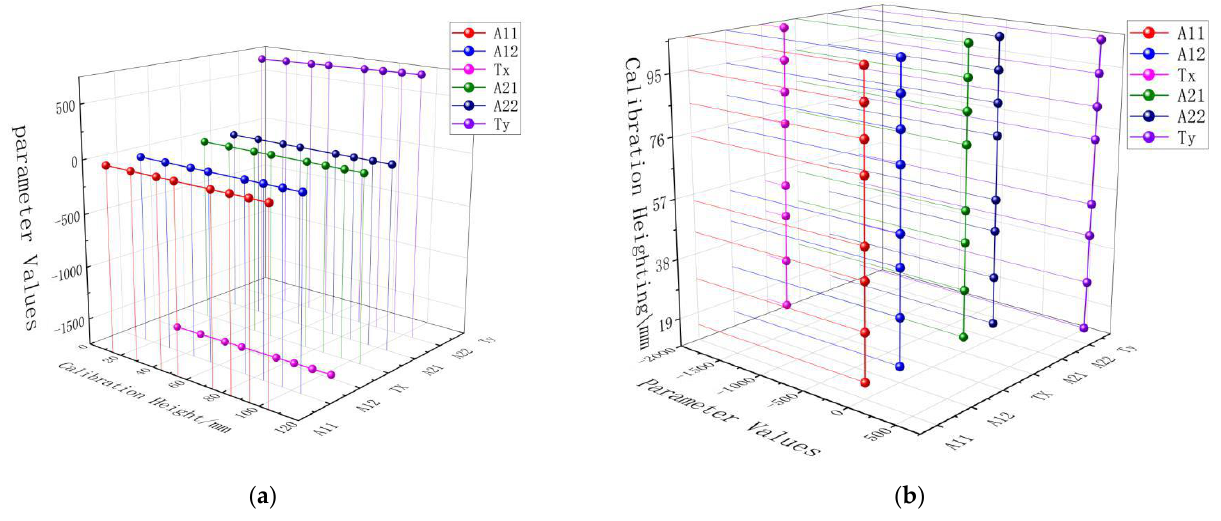
Figure 10. Broken line diagram of rigid transformation matrix parameters and calibrated height parameters: ( a ) The Z − axis is the parameter value, and ( b ) Z − axis is the calibration height. It can be seen from Figure 10 that 𝑀 𝐶𝑅 matrix parameters show an obvious linear rlationship with the broken line diagram of H . Tx and Ty reflect the change in the trans- lation matrix. A11, A12, A13, and A14 are all near the z = 0 plane, which is also fully consistent with the rotation matrix parameters proposed by us. According to Table 4, we